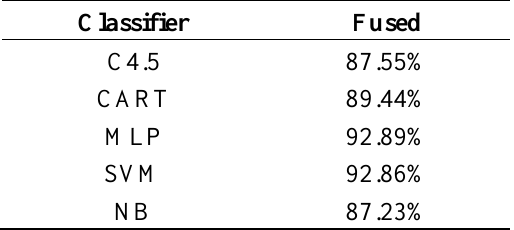
Table 6. Overall PCA results for smartphone.